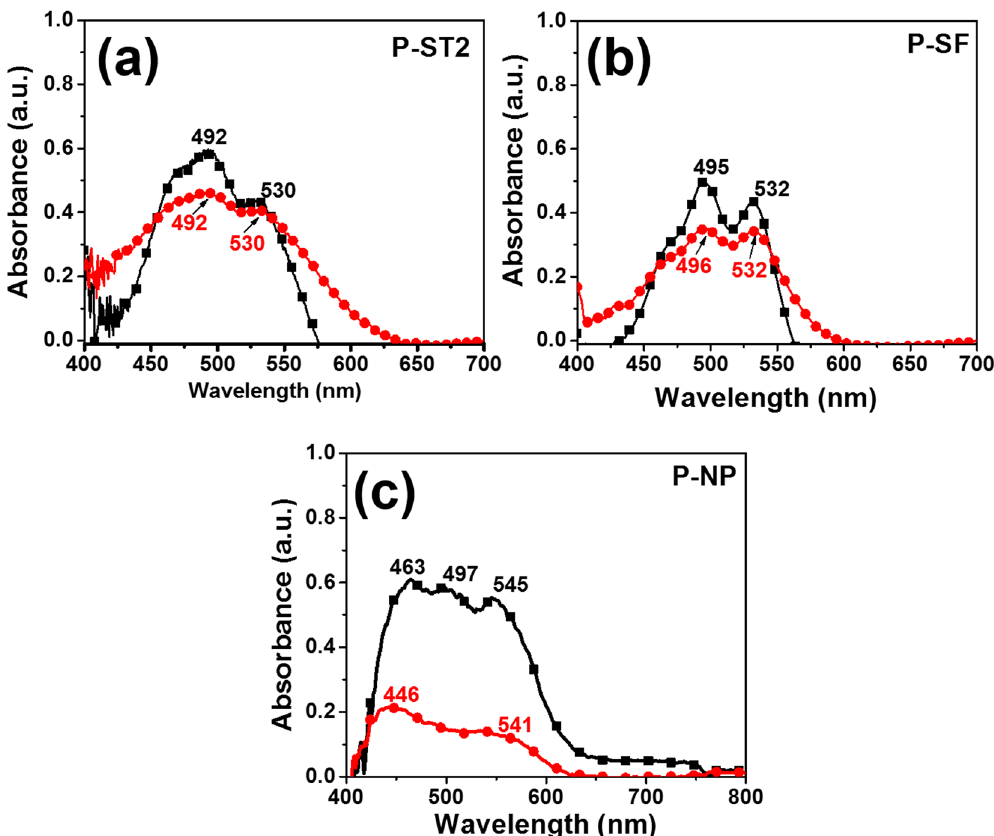
Figure 5. Polarized UV/Vis absorption spectra of perylene silica nanoparticles ( a ) P-ST2 , ( b ) P-SF and ( c ) P- NP with the samples set parallel (||, ■ ) and perpendicular ( ⊥ , ) to the